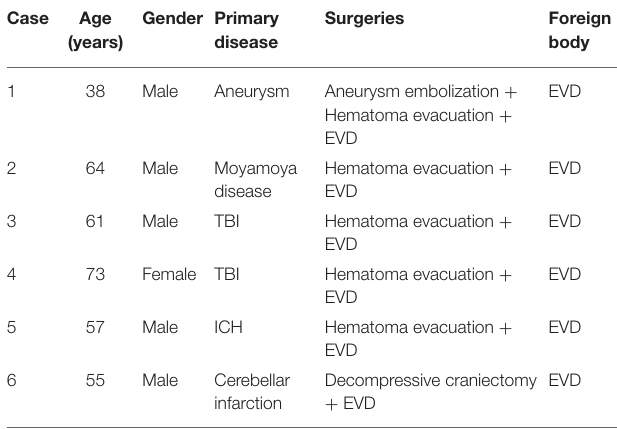
TABLE 2 | Clinical characteristics of patients enrolled in the